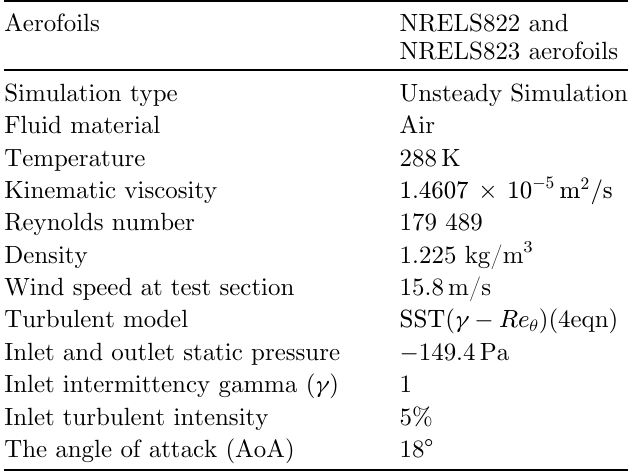
Fig. 3. The computational domain of the NRELS822 aerofoil. Table 2. Optimum computational conditions for aerofoil simulations.